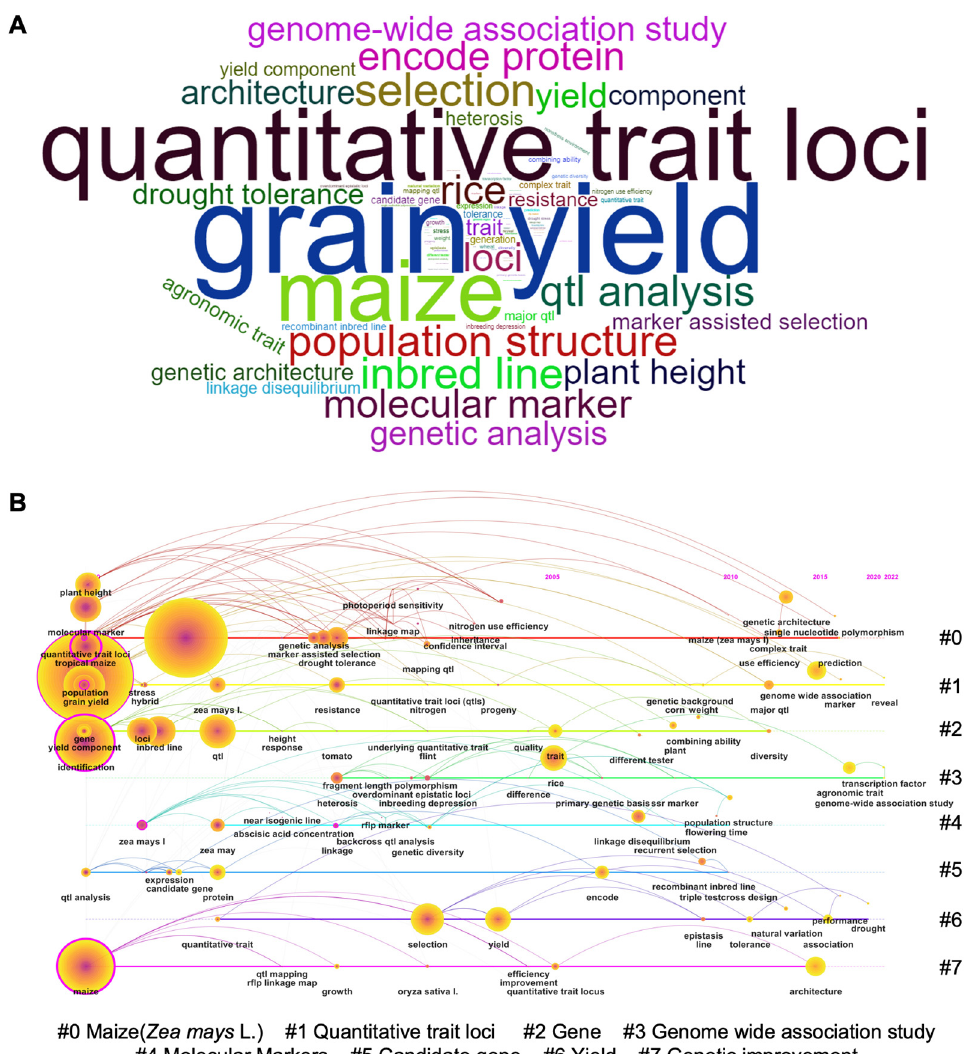
Figure 3. Hot topics and the knowledge structure of kernel size and seed weight in maize. ( A ) Word cloud of kernel research in maize. ( B ) Sequence diagram of eight clusters of keywords in maize kernel size-related research. Nodes are labeled with corresponding topics.